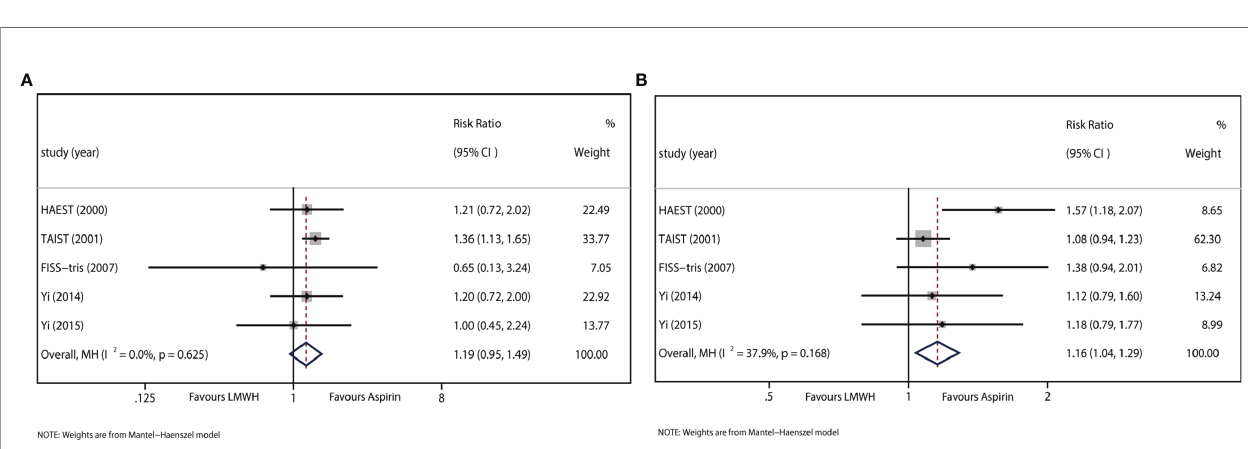
FIGURE 2 | (A) Forest plot of the effects of LMWH vs. aspirin on the outcome of END. (B) Forest plot of the effects of LMWH vs. aspirin on the outcome of RIS.